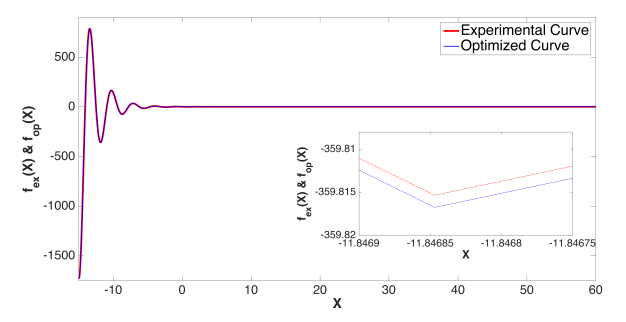
Figure 7. Extrapolation of the case study 2.